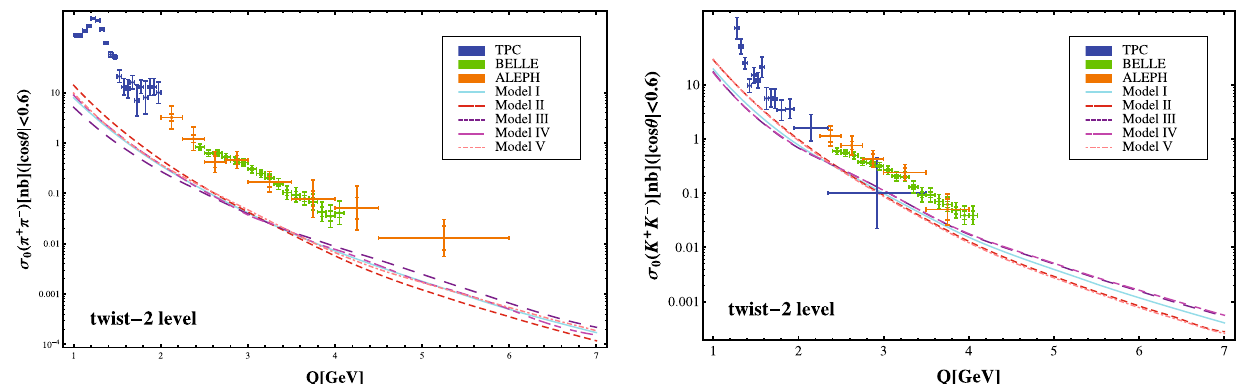
Fig. 2 Twist-2 results of the cross sections σ 0 (π + π − ) and σ 0 ( K + K − ) with the five sample models of the distribution amplitudes listed in Table. 2. The points with errors are the experiment data from Refs. [12,13,15]